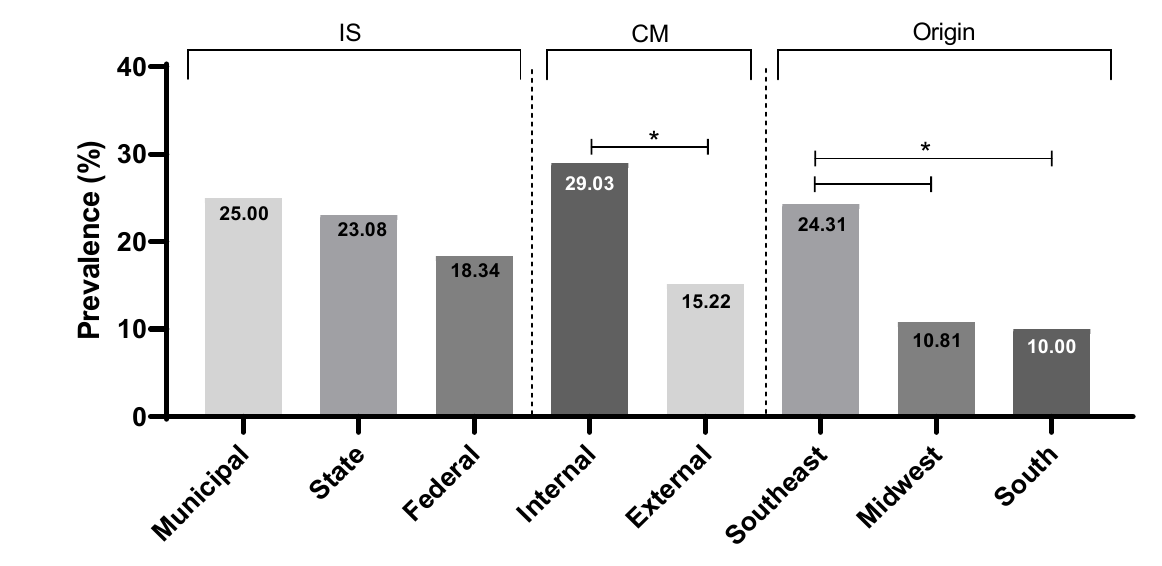
Figure 1. Prevalence of Campylobacter spp. in chicken carcasses according to the inspection system, * p < 0.05, Fisher’s exact test.